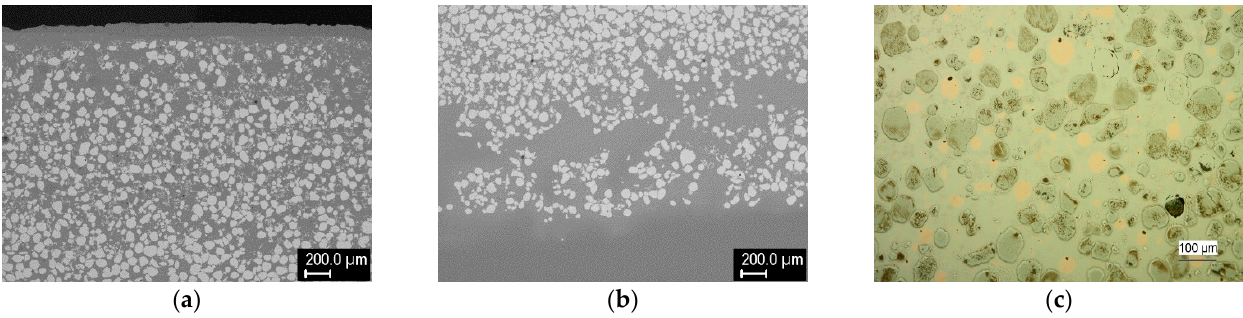
Figure 7. Cross sections of W–Cu cladding made from 75% W mixture on a steel substrate: ( a ) overview near the top, ( b ) overview near the substrate, ( c ) detail of a middle region (light microscopy for better distinction of the Cu grains in the steel matrix).